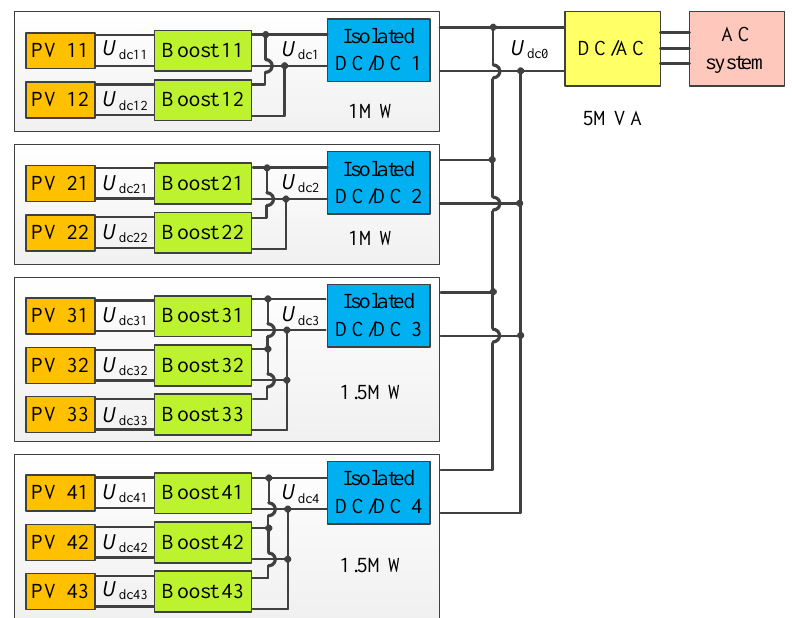
Figure 11. The PV integration system model in MATLAB/Simulink.